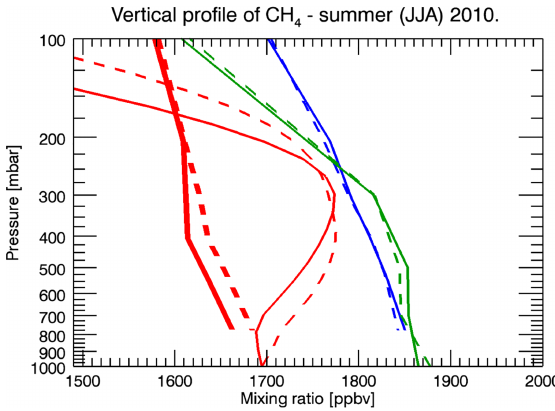
Figure 23. Summer averaged vertical profiles of CH 4 as measured by AIRS (blue lines) and GOSAT (green lines), and as calculated by MOCAGE (thin red lines) over the eastern (dashed lines) and western (solid lines) Mediterranean basins in summer 2010. Also shown are the seasonally averaged MOCAGE profiles convolved with the AIRS averaging kernels (thick red lines) for the summer over the eastern (dashed lines) and western (solid lines) Mediter- ranean basins (adapted from Ricaud et al.,